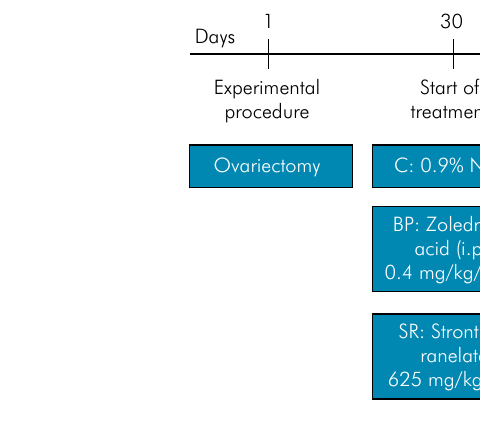
Figure 1. Schematic representation of the experimental